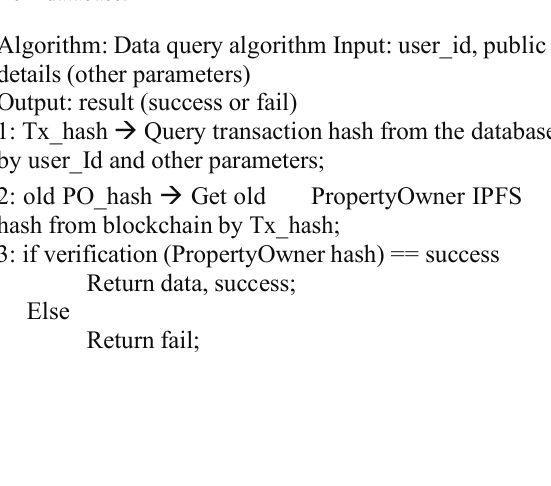
Figure 4.3 Data analysis after querying owner information from